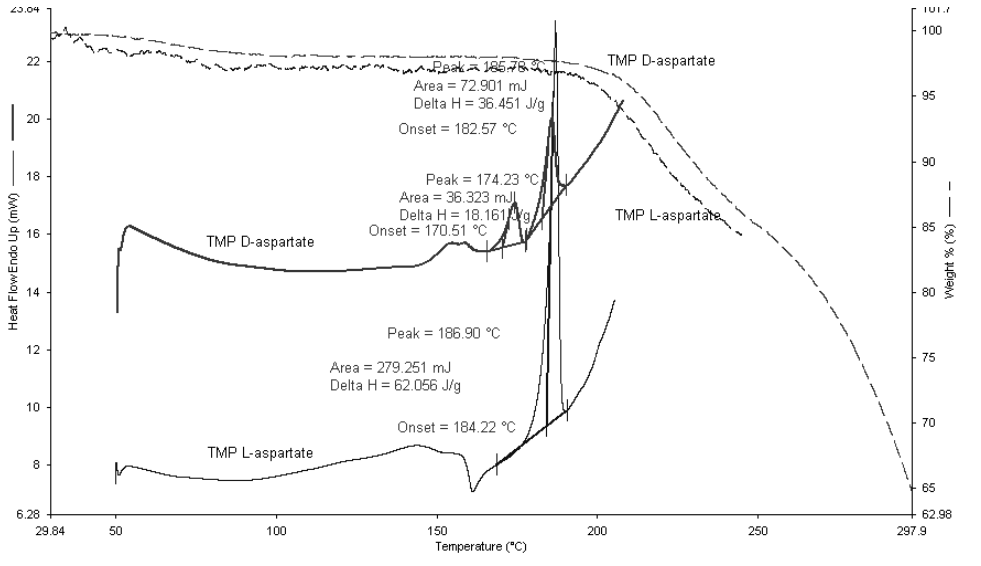
Figure 7. DSC and TGA scans for TMP D -aspartate and TMP L -aspartate. 2–5 mg of the sample was heated to 300 °C at rate of 10 °C/min